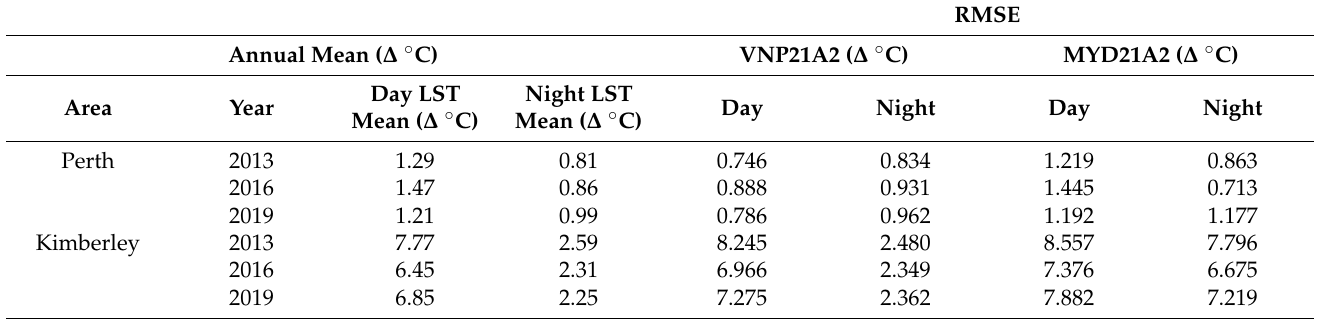
Table 4. Comparison of the yearly temperature differences for 2013, 2016, and